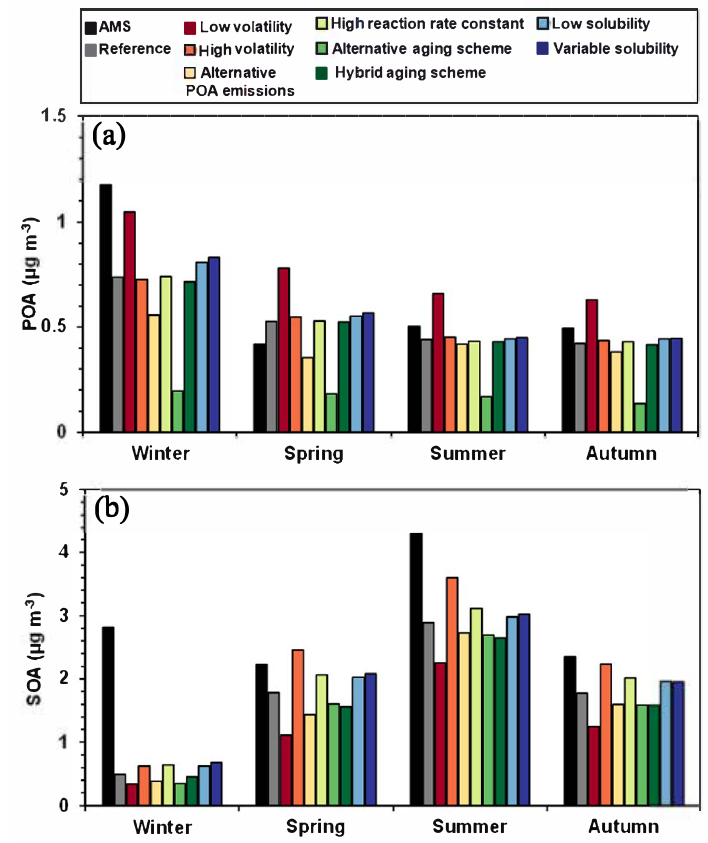
Figure 8. Average (a) POA and (b) SOA concentrations (in µgm − 3 ) measured and predicted in the reference and sensitivity simulations during winter, spring, summer, and autumn in urban-downwind and rural areas of the continental Northern